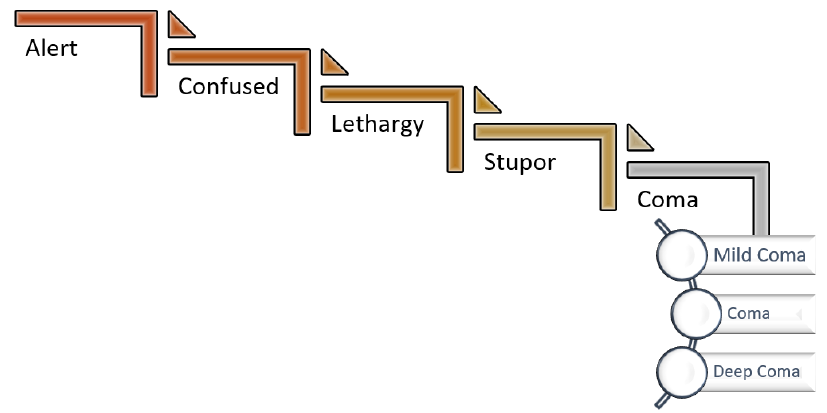
Figure 1. Altered level of consciousness